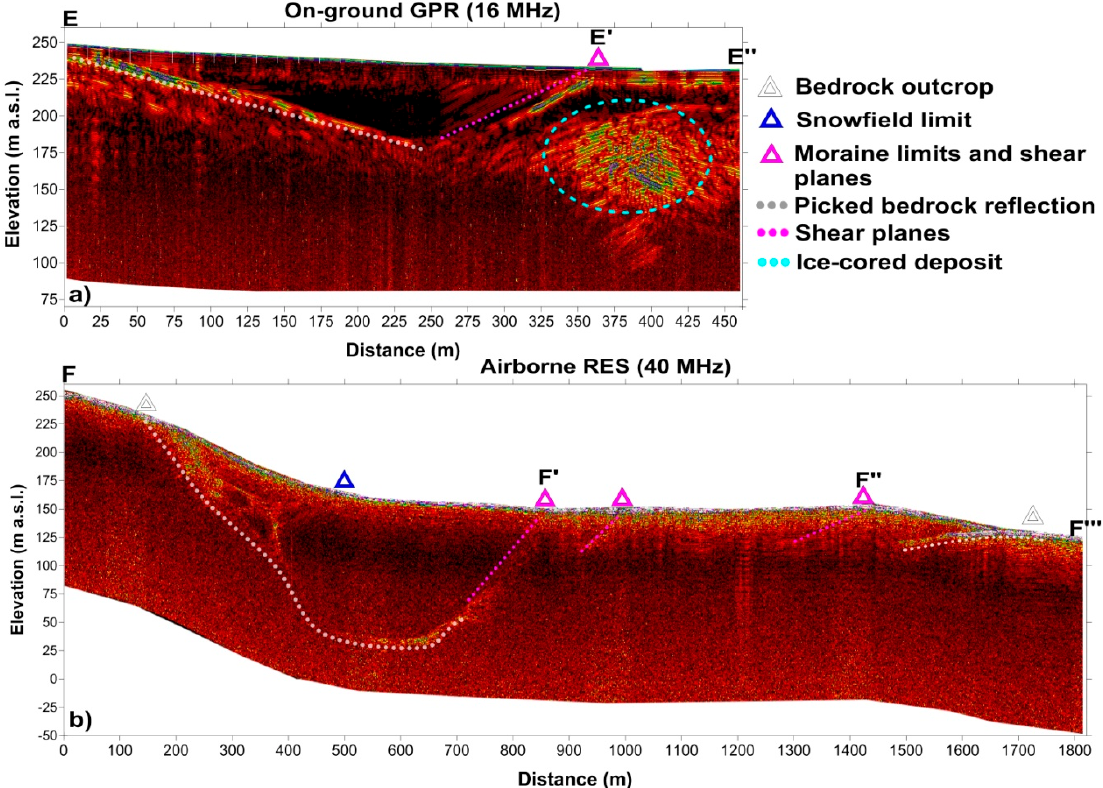
Figure 9. Cross-sections radargrams as showed in Figure 7: ( a ) radargram EE’; ( b ) radargram FF’ (vertical exaggeration: 2).